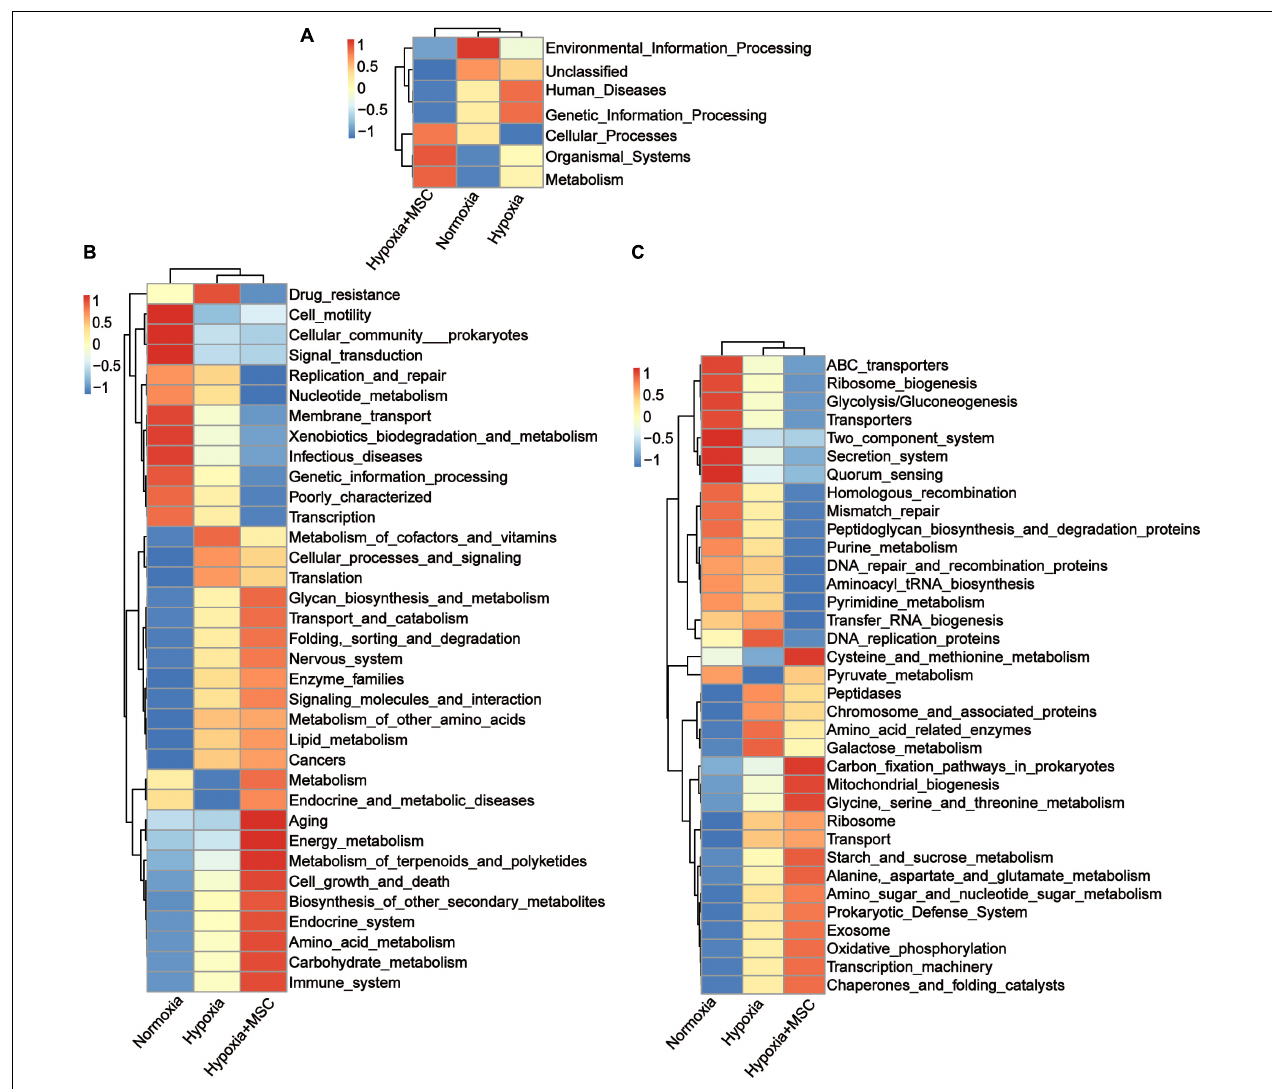
FIGURE 5 | Kyoto Encyclopedia of Genes and Genomes (KEGG) pathway analysis at level 1 (A) , level 2 (B) , and level 3 (C) . Statistically significant KEGG pathways of the normoxia, hypoxia-induced and MSC-treated groups were determined by STAMP software, and LEfSe (LDA score > 2) of significant KEGG pathways was